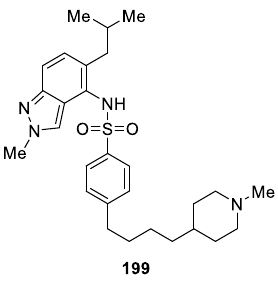
Figure 71. Chemical structure of 2 H -indazole derivative 199.